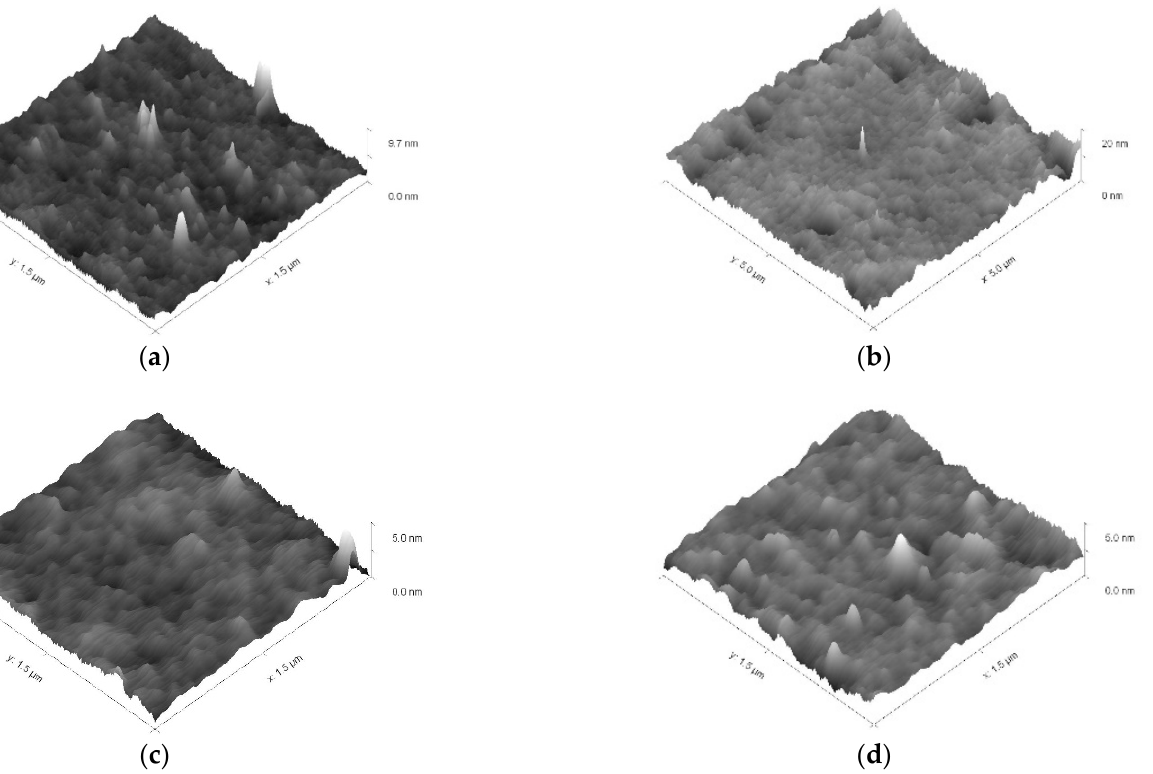
Figure 9. AFM images of polymers modified by [ASiP–AGM-10] = 0 ( a ), 0.1 ( b ), 0.2 ( c ) and 0.3 ( d ) wt.%.